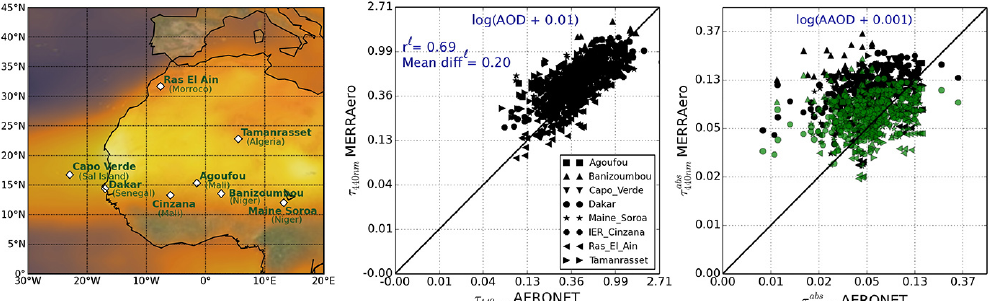
Figure 5. Comparison of MERRAero and AERONET 440nm AOD (middle) and AAOD (right) using the OPAC dust optics in black and the observation-based dust optics in green at eight Saharan dust AERONET sites shown on the map (left) for the period June to October 2007. The one-to-one correspondence is indicated by the black line. r l and mean diff l are the correlation coefficient and the mean difference of the log-transformed AOD.